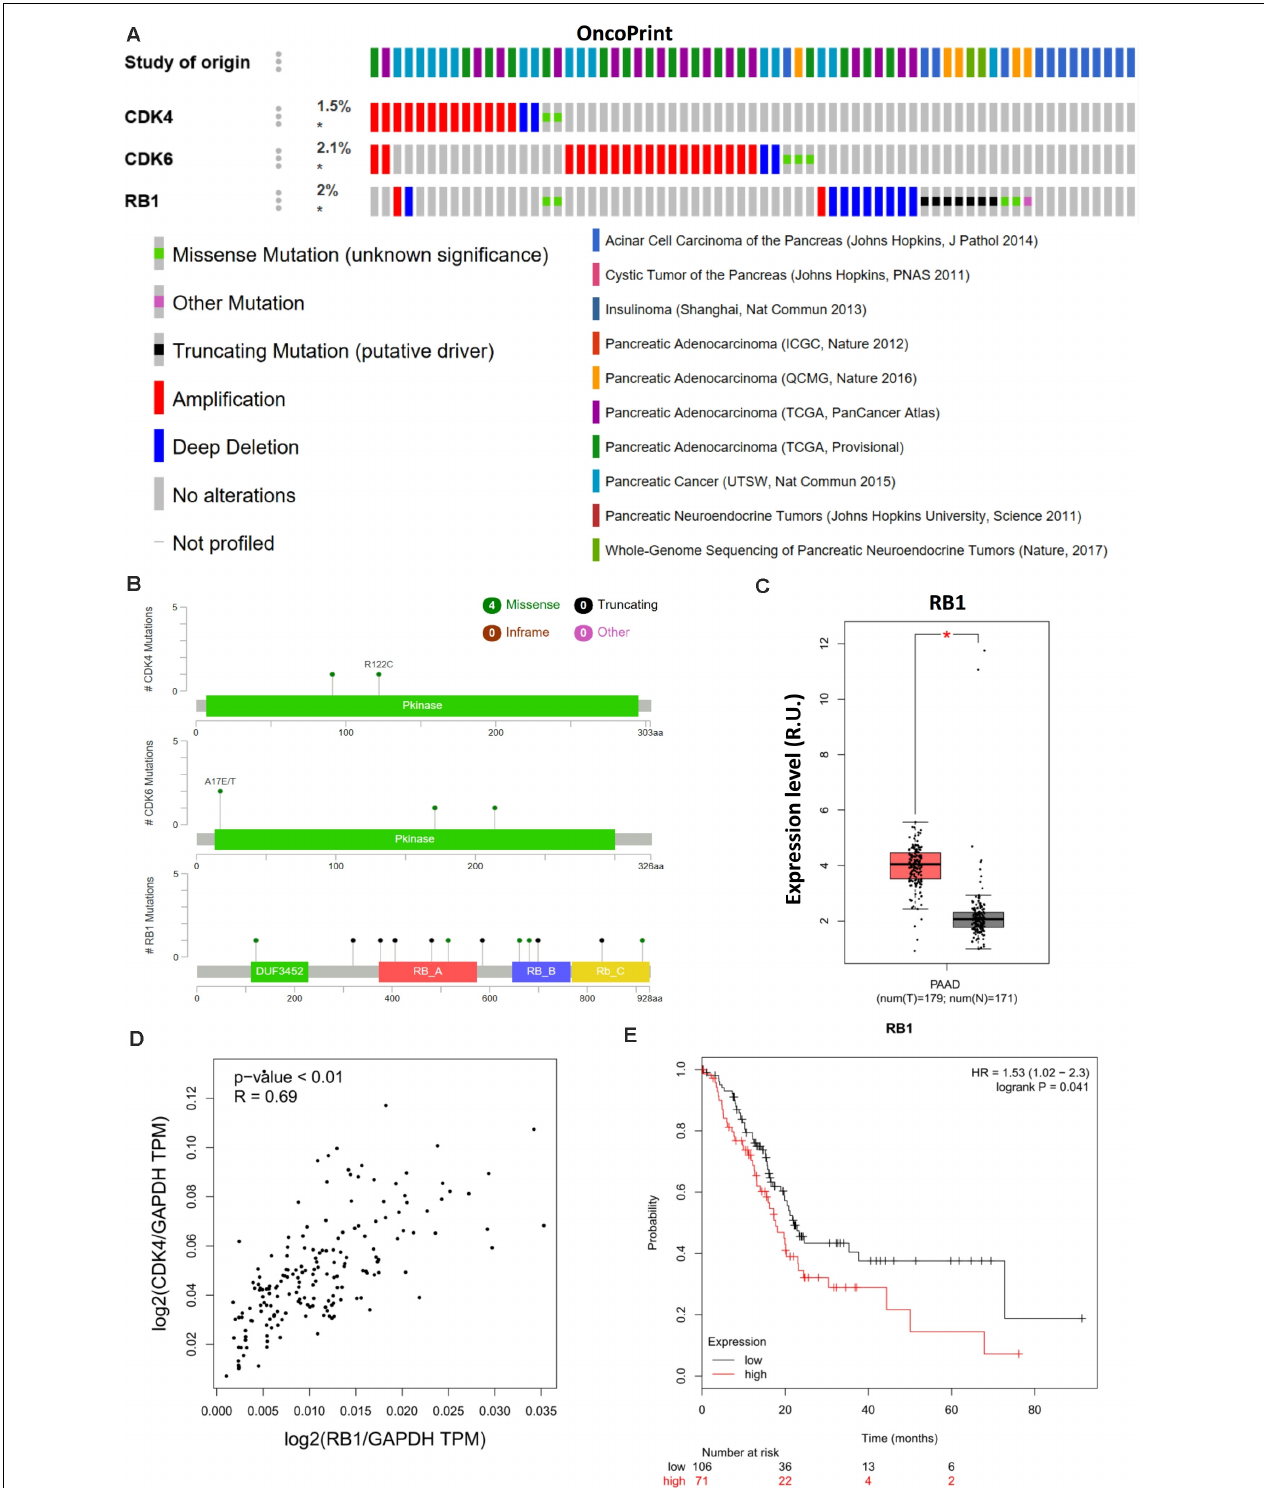
FIGURE 3 | RB1 couples with CDK4 and is related to poor prognosis in pancreatic cancer. (A) Landscape of the CDK4/6–RB1 axis in pancreatic cancer. Compact visualization of cases with different genetic alterations, including fusions, amplification, deletions, truncating mutations, and missense mutations. (B) Detailed mutational analysis of CDK4, CDK6, and RB1 in pancreatic cancer. (C) Differential expression analysis of RB1 in PAAD. (D) Correlation analysis of RB1 and CDK4 in PAAD. (E) OS analysis of RB1 in PAAD. P -values ≤ 0.05 were considered statistically significant. ∗ p ≤ 0 . 01.